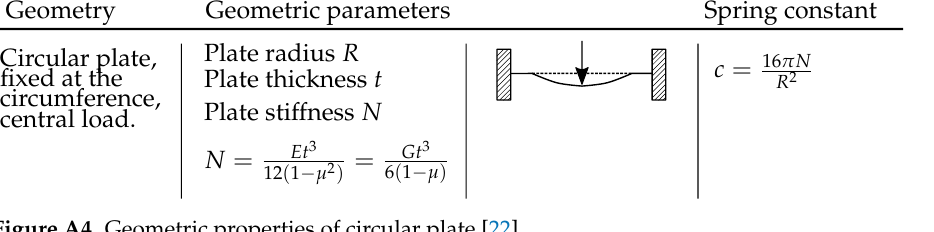
Figure A4. Geometric properties of circular plate [22].